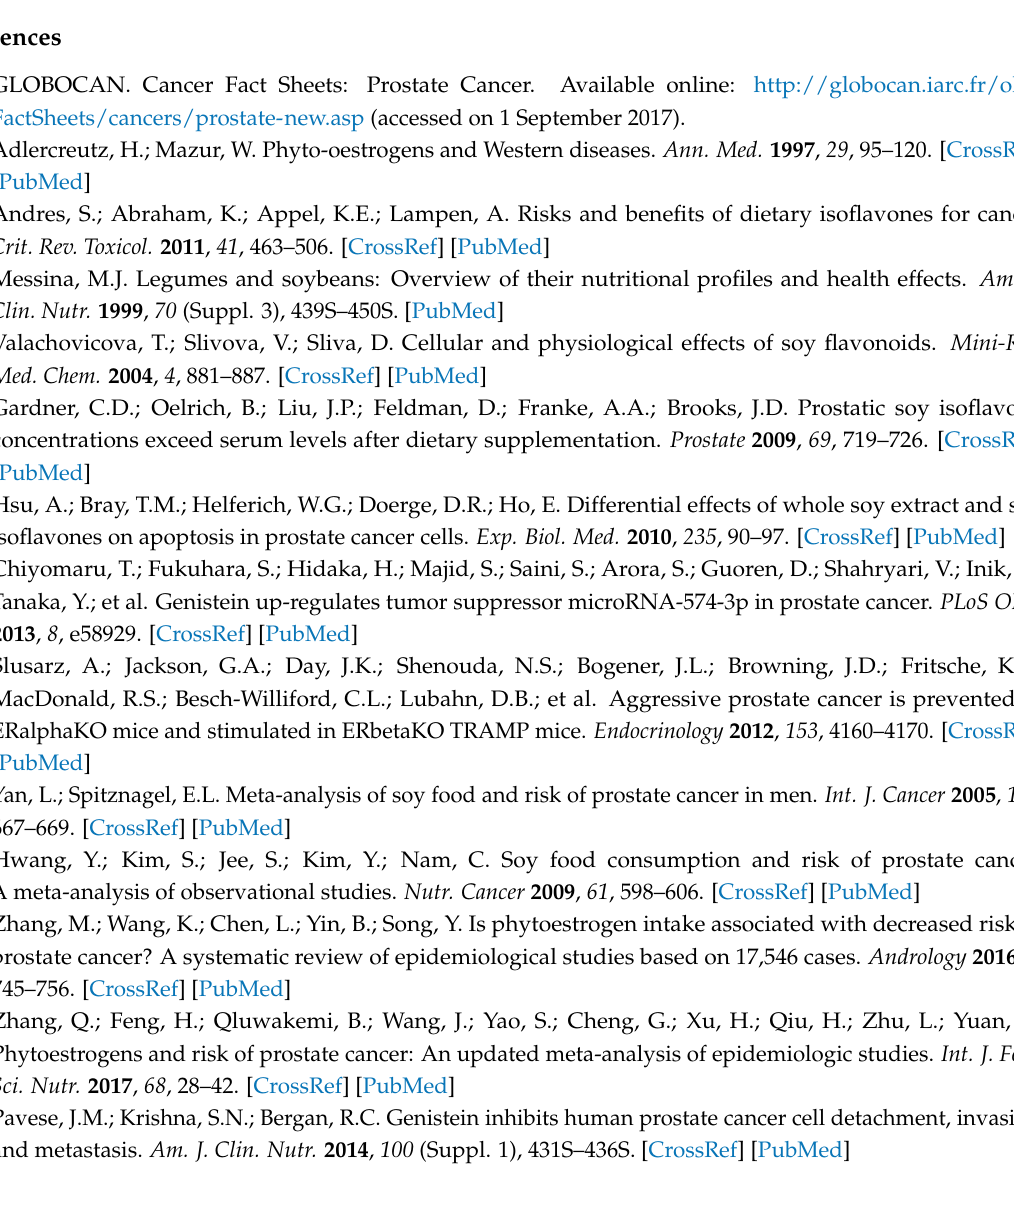
Figure A4. Funnel plot for total soy intake and risk of advanced prostate cancer.